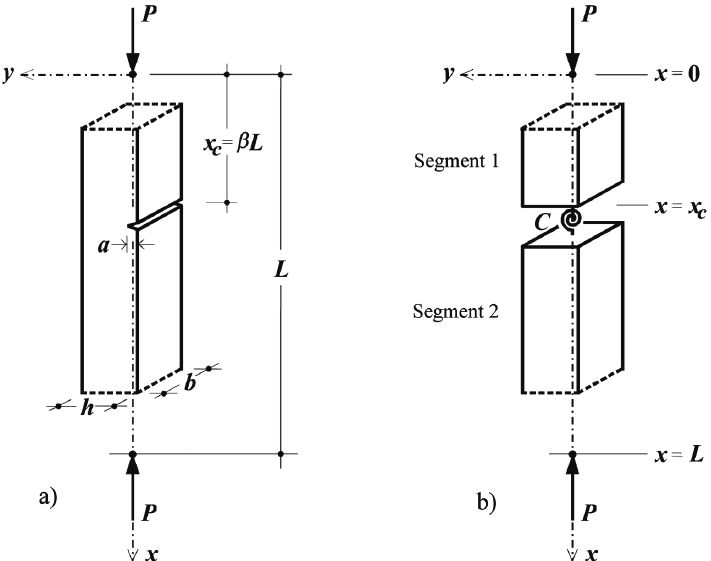
Fig. 1. A slender column with a non-propagating edge crack (a); its physical model